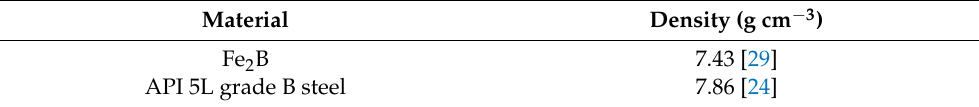
Table 3. The density of the corresponding hardening surfaces is according to Equation (5) [28].